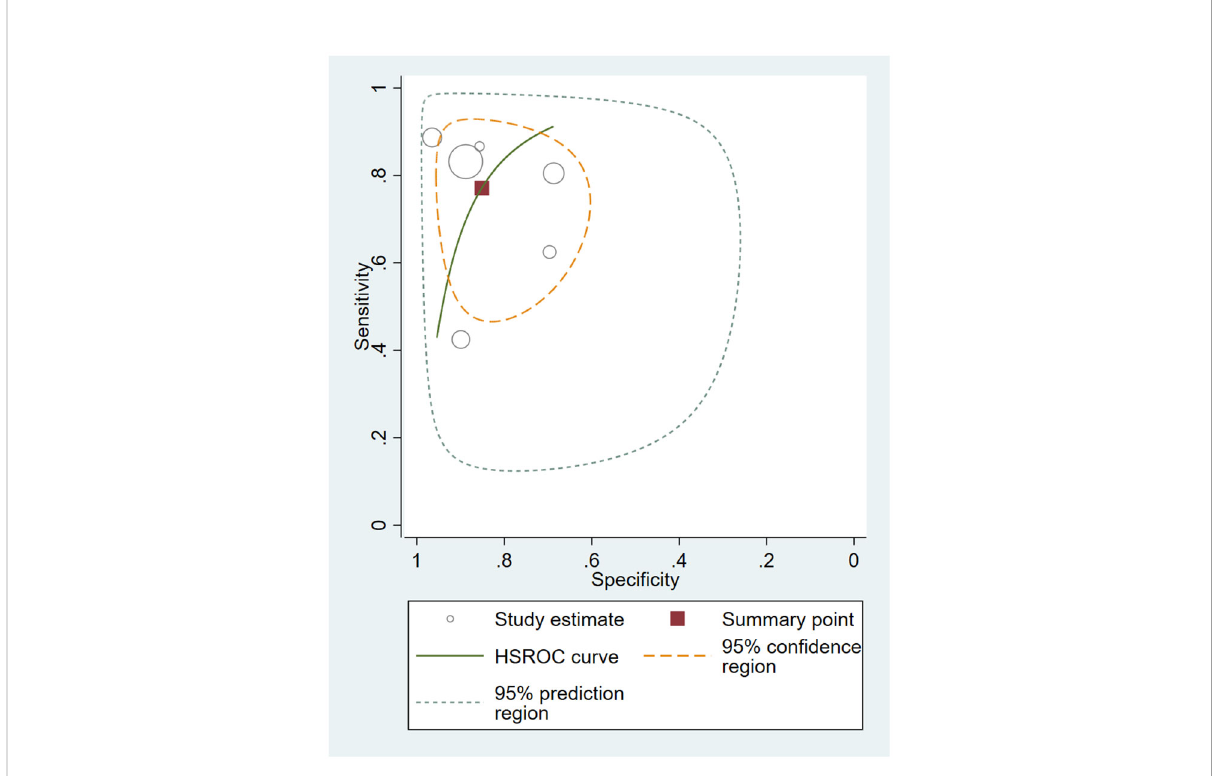
FIGURE 4 Hierarchical summary receiver operating characteristic (HSROC) curves for all included